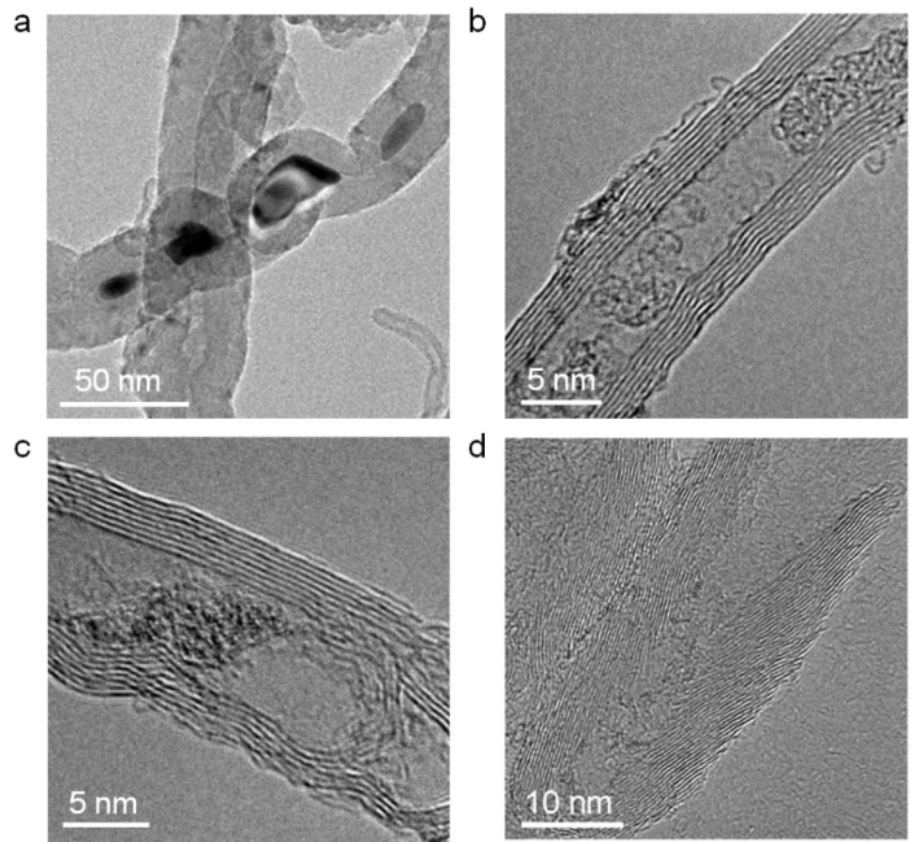
Figure 3. ( a – c ) TEM images of residual catalyst, amorphous graphite and an internal defect in the mid-section of CNTs are displayed, respectively. ( d ) A TEM image of an ultra-short CNT. The efficiency of preparing the ultra-short CNTs can be described using the mass ratios of M short : M raw , which is equal to the mass of ultra-short nanotubes divided by the mass of raw nanotubes. The M short : M raw for the 6 nm-wide MWCNTs and the 20–50 nm-wide MWCNTs were 0.68 and 0.80, respectively (Table S1). The mass losses were ascribed to the removed impurities and some ultra-short CNTs lost during the cleaning processes. If the mass loss during the cleaning processes can be reduced in the future, the applicability of this study will be strong. Figure 4 shows that the zeta potentials of the two kinds of MWCNTs decreased with the ball milling duration. For the same ball milling time, the wider MWCNTs had a lower zeta potential than the thinner MWCNTs, which can be attributed to the thicker MWCNTs having more negatively charged functional groups on their side walls and ends than the thinner MWCNTs [44,46]. The two kinds of ultra-short CNTs subjected to ball milling for 24 h were dispersed in deionized water using ultrasonic treatment to form suspensions with a concentration of 0.04 wt %, as shown in the insert of Figure 4. No precipitations were observed in the suspensions upon standing for 100 days. However, the raw long CNTs at the same concentration aggregated within one hour (Figure S1). Zeta potentials give an indication of the potential stability of a system, where high zeta potentials (either negative or positive) indicate electrically stabilized particles, while colloids with low zeta potentials tend to coagulate or flocculate [46]. For the purposes of this study, a better CNT dispersion was considered to benefit their